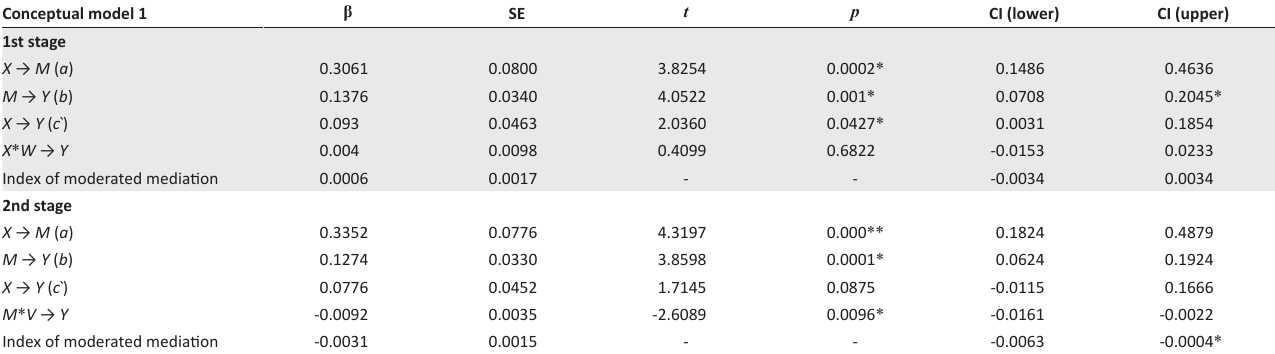
TABLE 3: Conceptual model 1: Moderated mediation results. Conceptual model 1